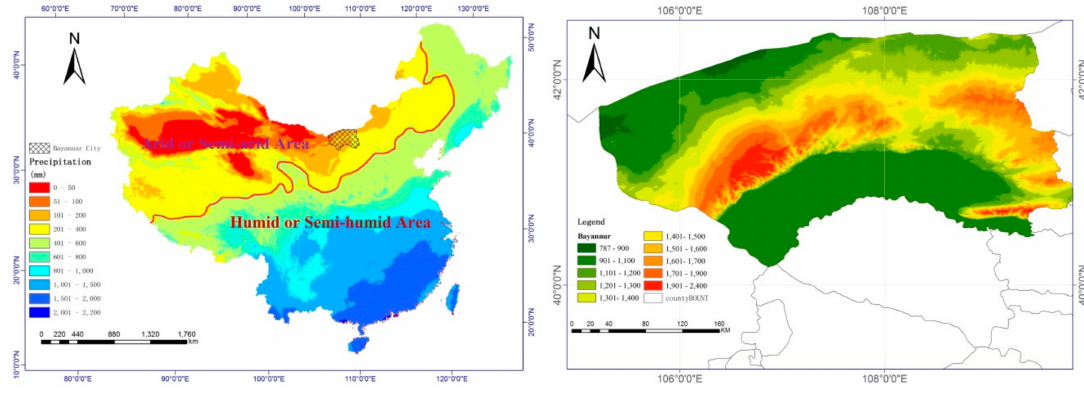
Figure 1. Location of the study